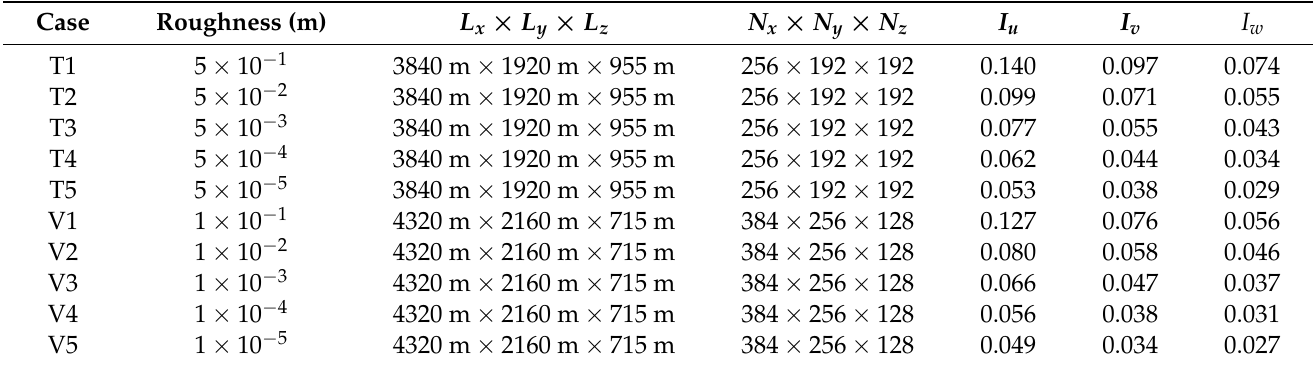
Table 1. Suite of LES simulations. Test cases and validation cases are denoted by T and V, respectively, while I u , I v , I w respectively correspond to the streamwise, spanwise, and vertical rotor-averaged turbulence intensity. The test cases are adapted from Vahidi and Porté-Agel